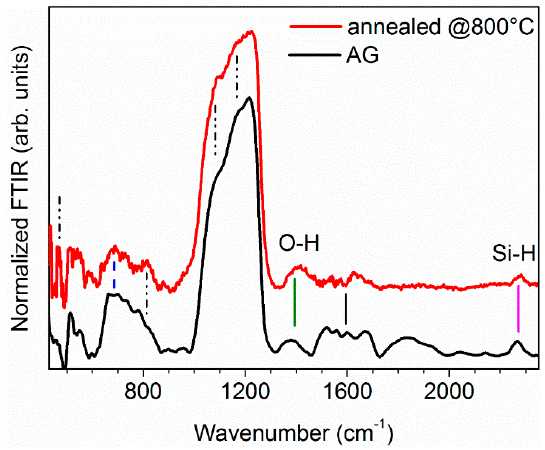
Figure A1. FTIR spectra of as-grown (AG) (black curve) and annealed (red curve) samples. The two spectra show peaks distinctive of the vibration modes of silicon oxide: i.e., the on-phase stretching (1082 cm − 1 ), the out-of-phase stretching (1177 cm − 1 ), the bending (812 cm − 1 ) and rocking − 1 (458 cm ) of Si-O-Si (see the dash-dot-dot black lines in Figure A1) [12,36]. However, for